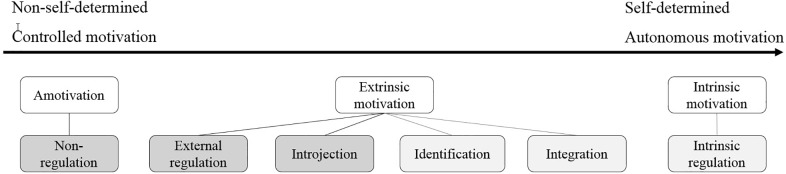
Self-determination theory adapted from Ryan and Deci (2000).